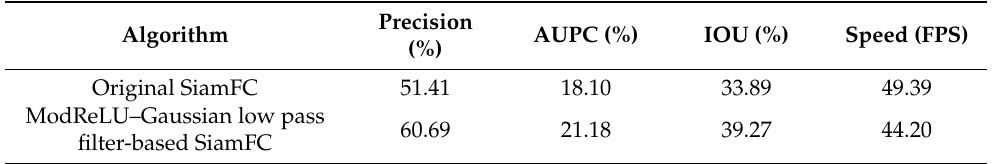
Table 5. Overall results comparison of the proposed ModReLU–Gaussian low pass filter-based SiamFC with original